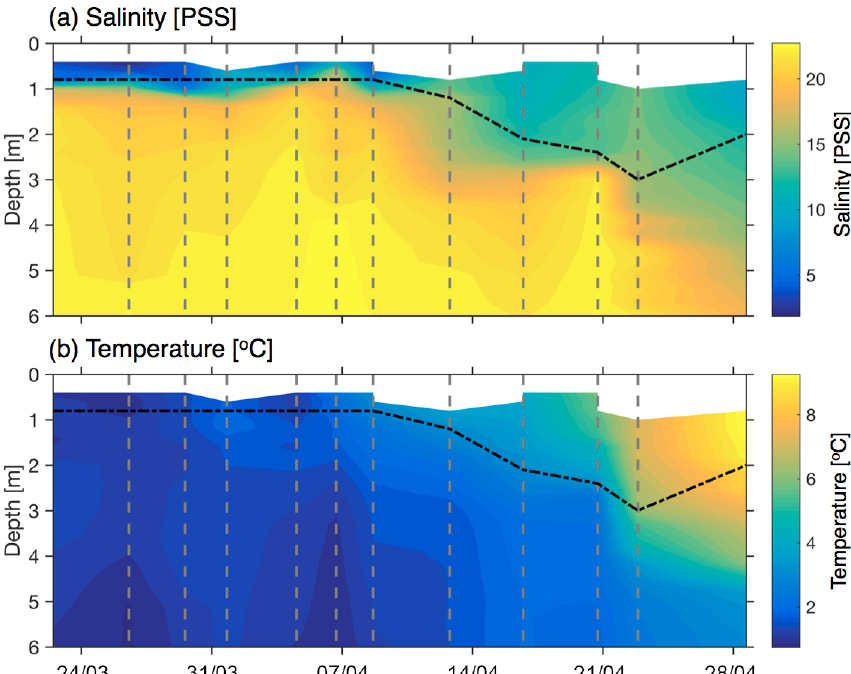
Figure 3. Temperature and salinity profiles at Little Narrows. (a) Salinity and (b) temperature profiles measured at Little Narrows. The vertical grey dashed lines indicate the timing of CTD casts (22, 26, 29, and 31 March, and 4, 6, 8, 12, 16, 20, 23, and 28 April). The black dot-dashed line shows the estimated mixed layer depth. The data in this plot were binned into 0.2m depth bins from 0.4 to 3.0 and 0.3m depth bins from 3.3 to 9.9m. The shallowest depth varies between casts due to challenges in getting stable CTD data in the upper 1m.